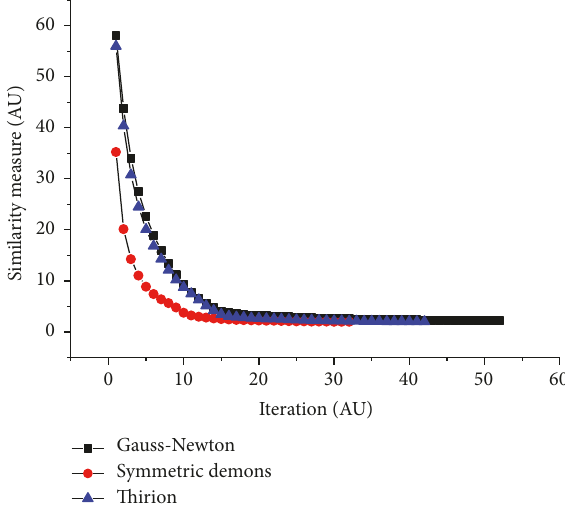
Figure 10: Comparison of three different demons driving